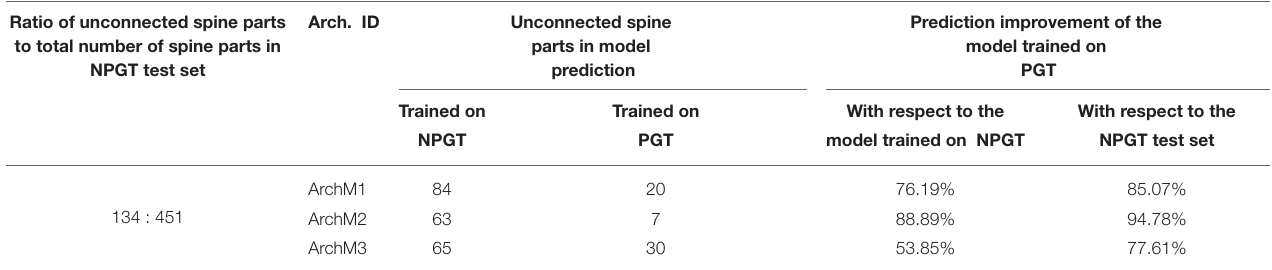
TABLE 2 | Comparison of models trained with and without preprocessing the GT using the test set. Ratio of unconnected spine parts to total number of spine parts in NPGT test set